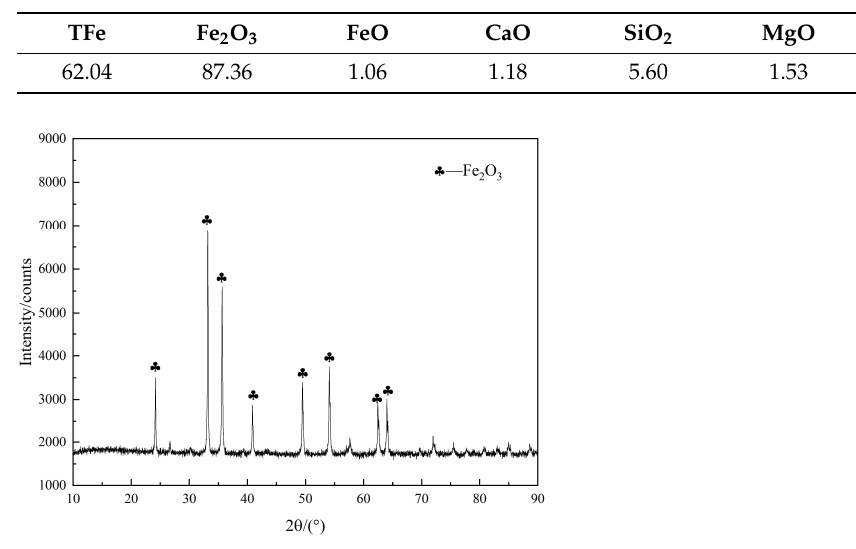
Table 1. Chemical composition of the iron ore fines (wt%).